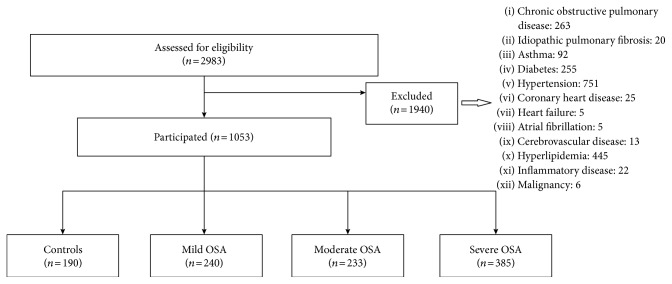
Study flow chart.